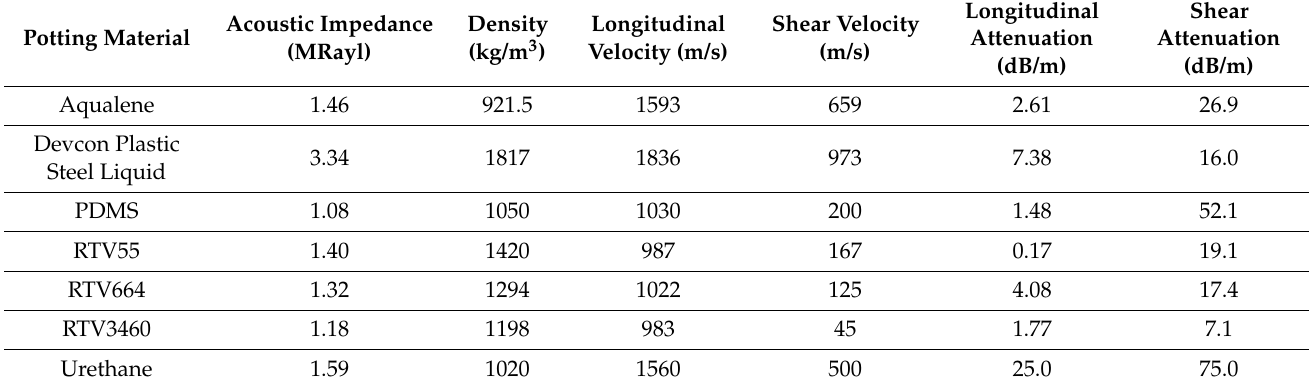
Table 4. Acoustic properties of the RTV materials.